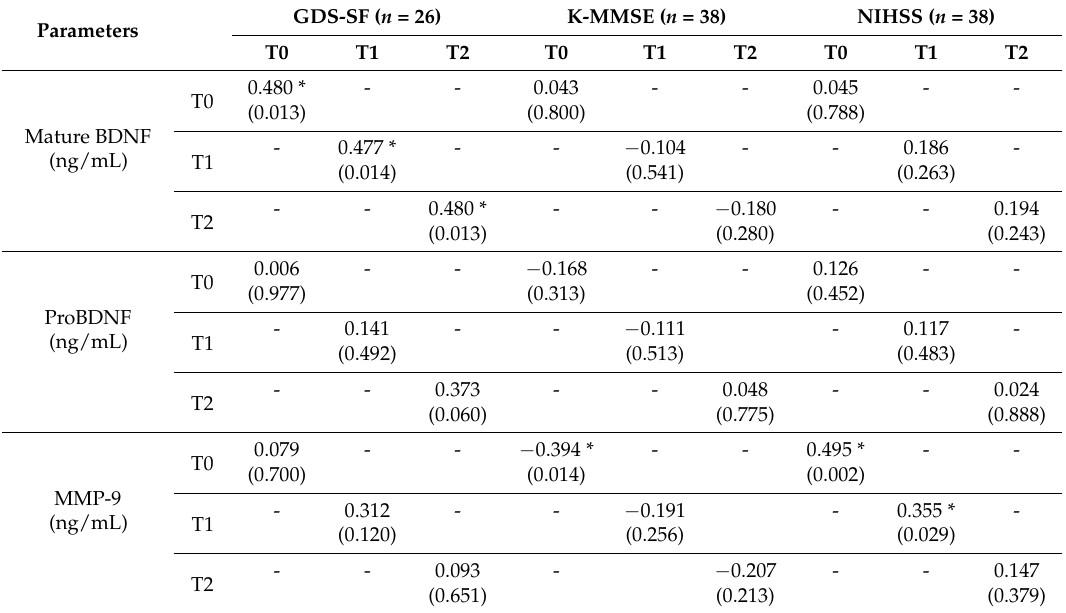
Figure 2. Relationships between mature BDNF levels and GDS-SF at each time point. There was a significant positive correlation between mature BDNF levels and GDS-SF at each time point. ( A ) Before the standard rehabilitation program (T0), ( B ) 1 week after the standard rehabilitation program (T1), ( C ) 2 weeks after the standard rehabilitation program (T2). BDNF, brain-derived neurotrophic factor; GDS-SF, Geriatric Depression Scale-Short Form. Table 3. Correlation analysis of serum levels of BDNF and clinical